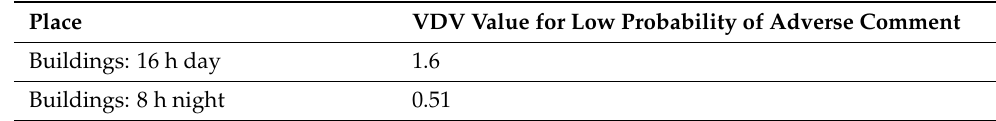
Table A2. VDV values to control the vibration performance of lightweight cold-formed steel floors according to SCI